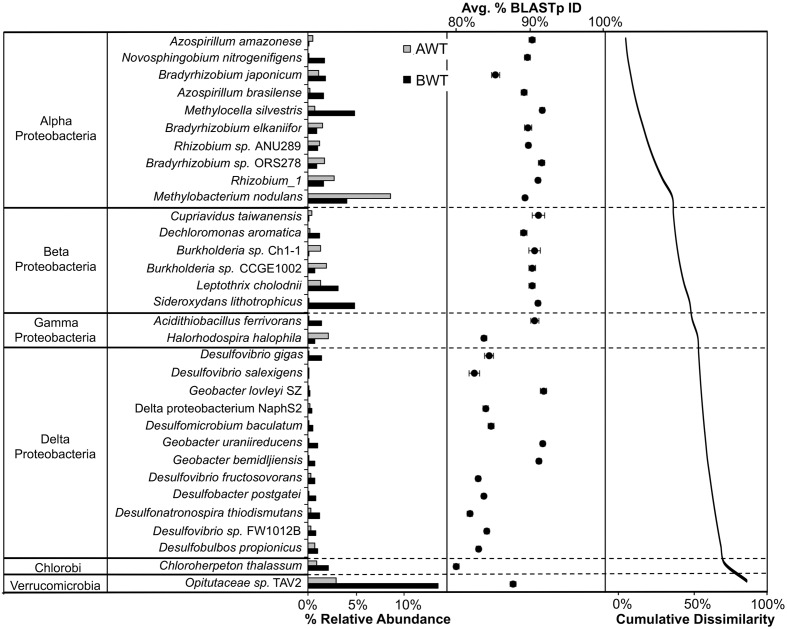
Similarity Percentage (SIMPER) analysis showing the representative sequence BLASTp closest match identity of the OTUs that contribute significantly to the discrimination between above water table (AWT) and BWT nifH-harboring bacterial communities. The OTUs shown contribute 79.1% of the cumulative dissimilarity, shown in the second pane. Average percent BLASTp identity with standard errors are shown in the third pane. These taxa account for 25.8% of all closest match reference taxa.